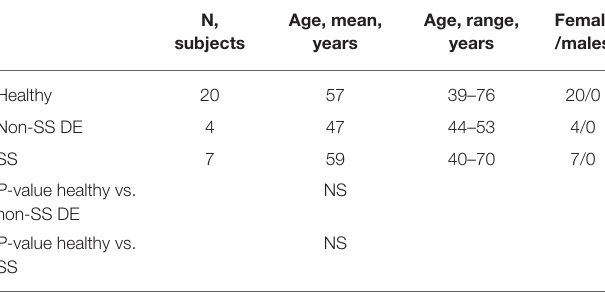
TABLE 1 | Demographic characteristics of study